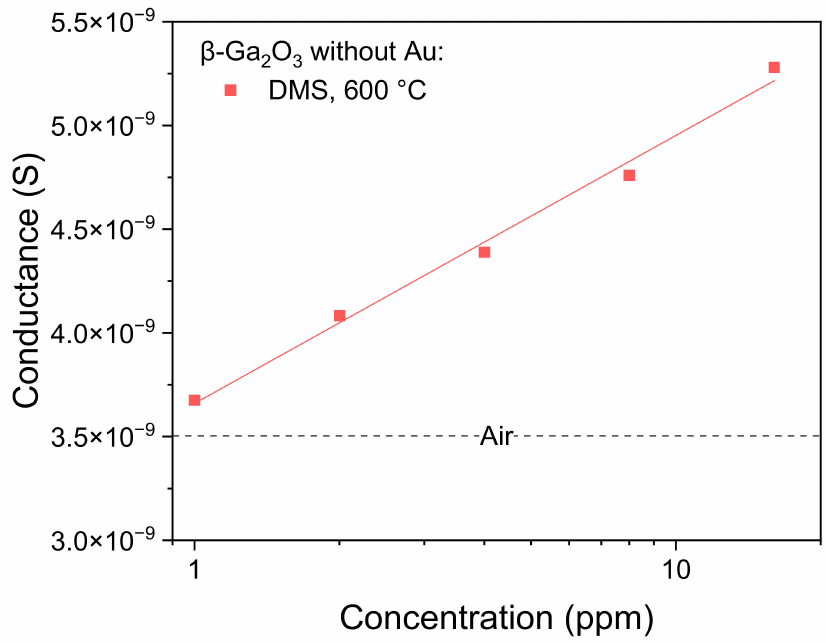
Figure 11. The conductance of the unmodified β -Ga 2 O 3 epitaxial layer as a function of dimethyl sulfide concentration in the air (T ≈ 20 ◦ C, RH ≈